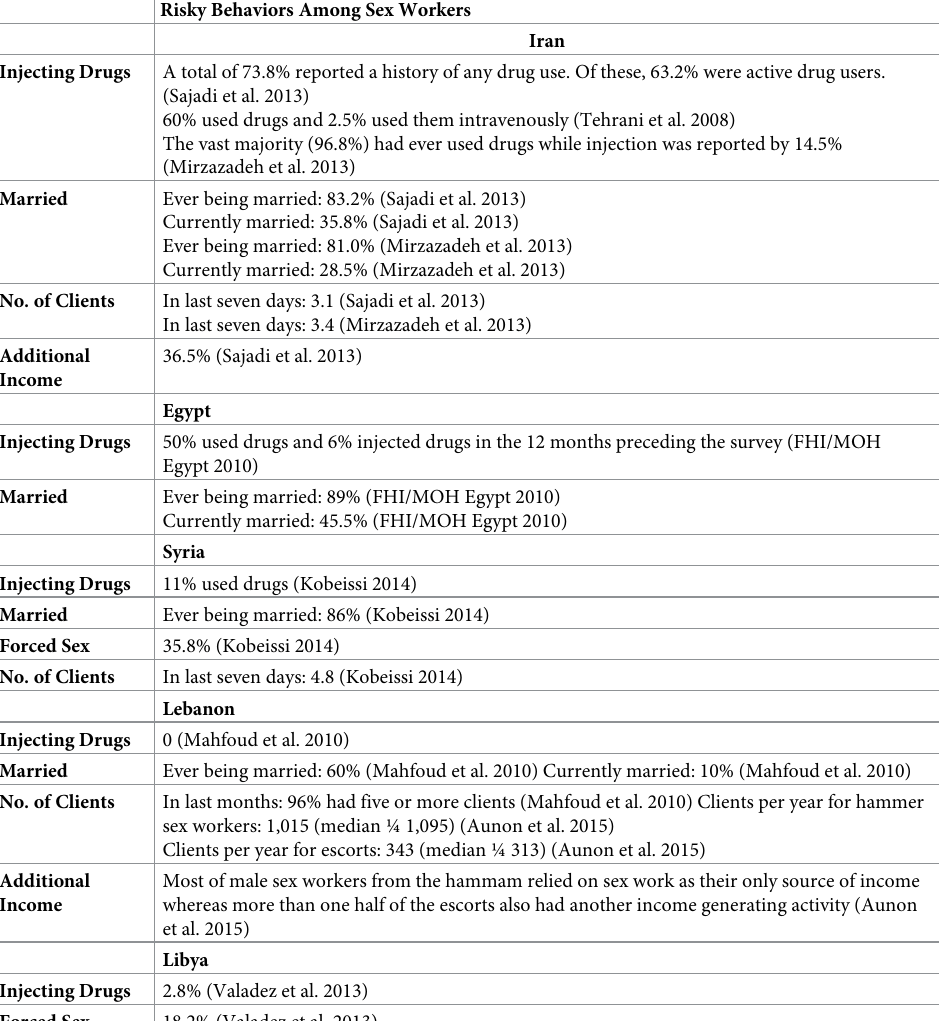
Table 4. Risky behaviors among sex workers in the MENA region. Risky Behaviors Among Sex Workers